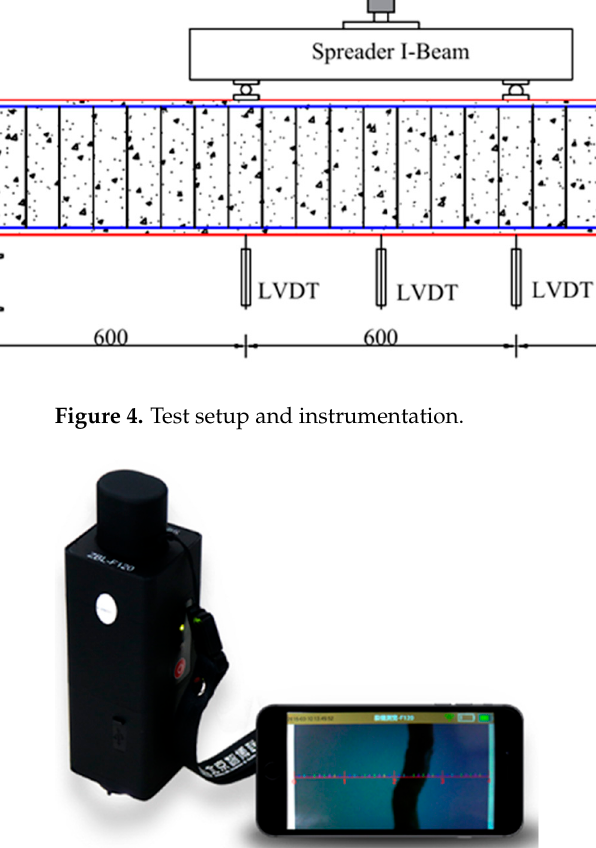
Figure 4. Test setup and instrumentation. Figure 5. Crack width detector. Figure 5. Crack width